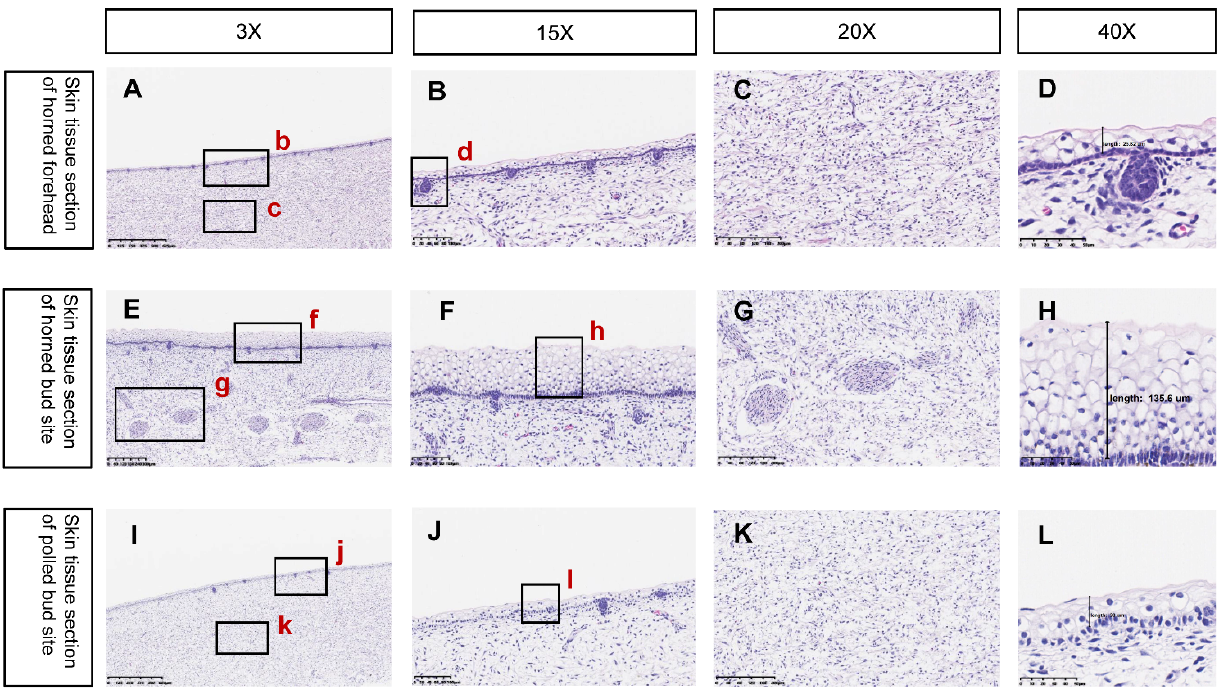
Figure 2. Phenotypic analyses of fetuses. ( A , C ) are horned Holstein 3-month-old fetuses, ( B , D ) are polled Holstein 3-month-old fetuses obtained by gene editing a pure insertion at the Pc locus from the enclosed horn bud sites in ( C , D ), it can be seen that there is distinct horn bud tissue at the horned horn buds.